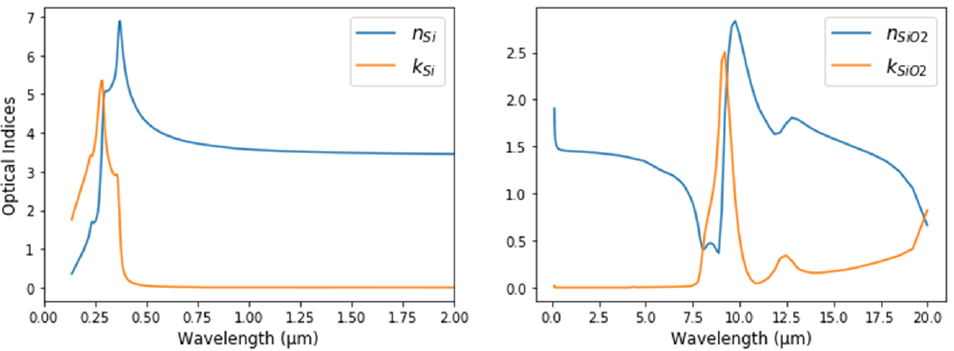
Figure 4. Optical indices of Si and SiO 2 used in the numerical demonstration. Table 1. Tauc-Lorentz parameters used to describe the dielectric function of Si 3 N 4 .